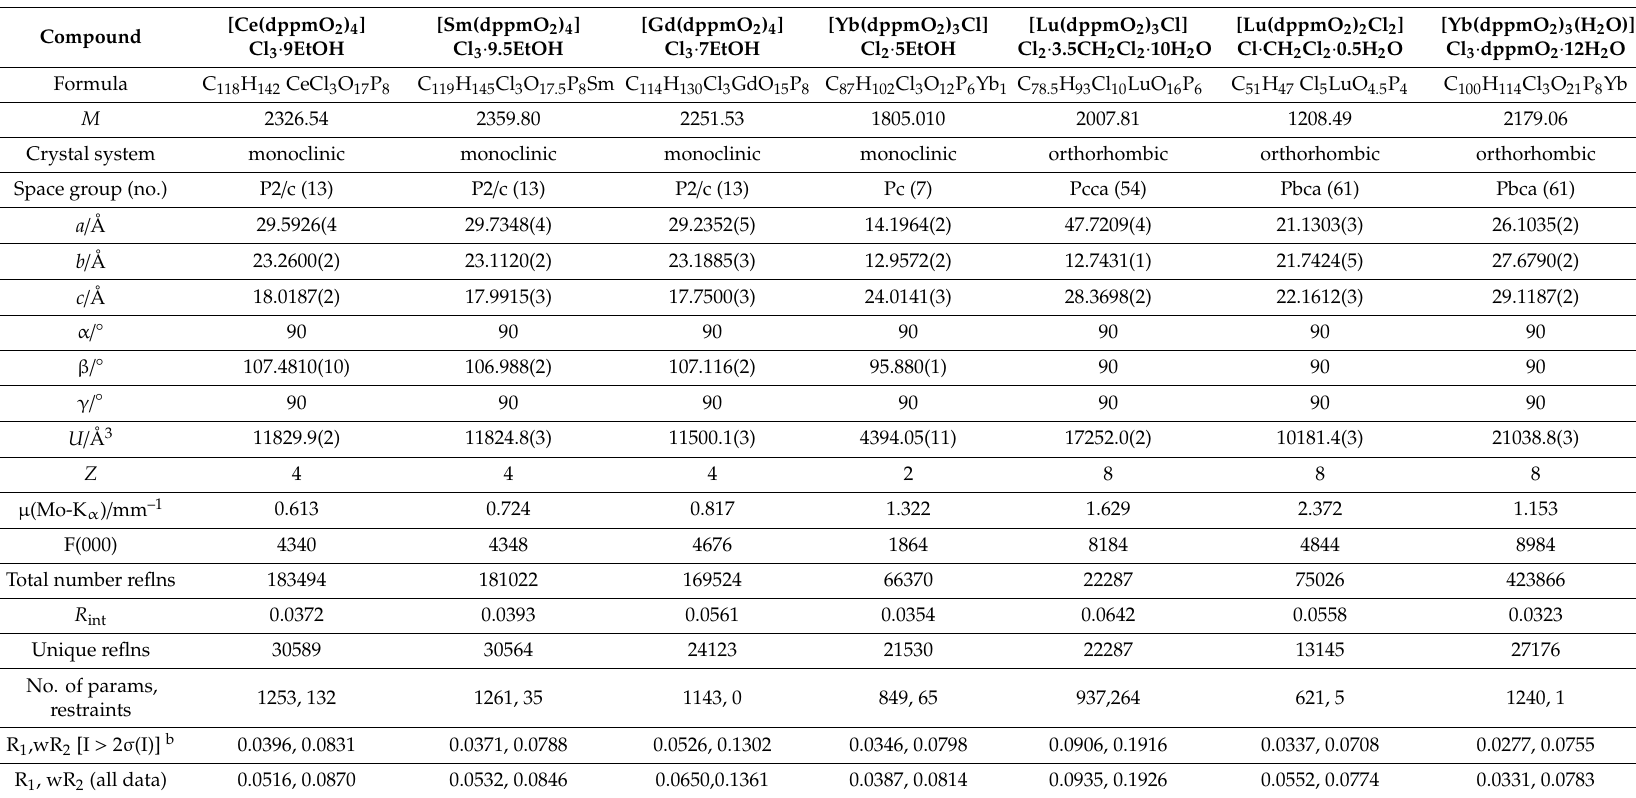
Table 1. X-ray crystallographic data a